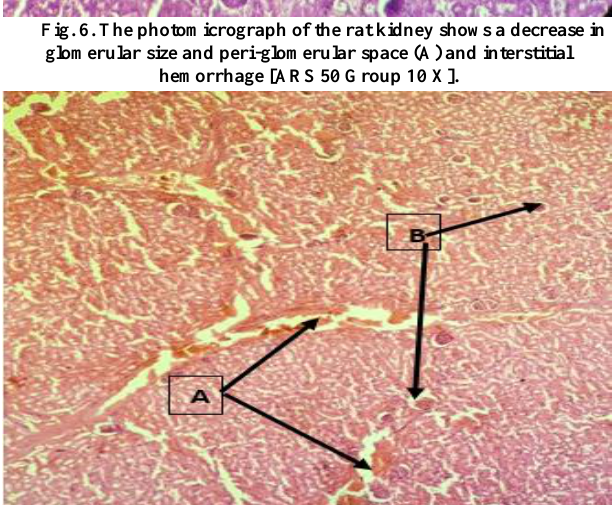
Fig. 7. Photomicrograph of rat kidney showing Extensive interstitial hemorrhage (A) and a marked increase in peri-glomerular space(B) [ARS 100 group